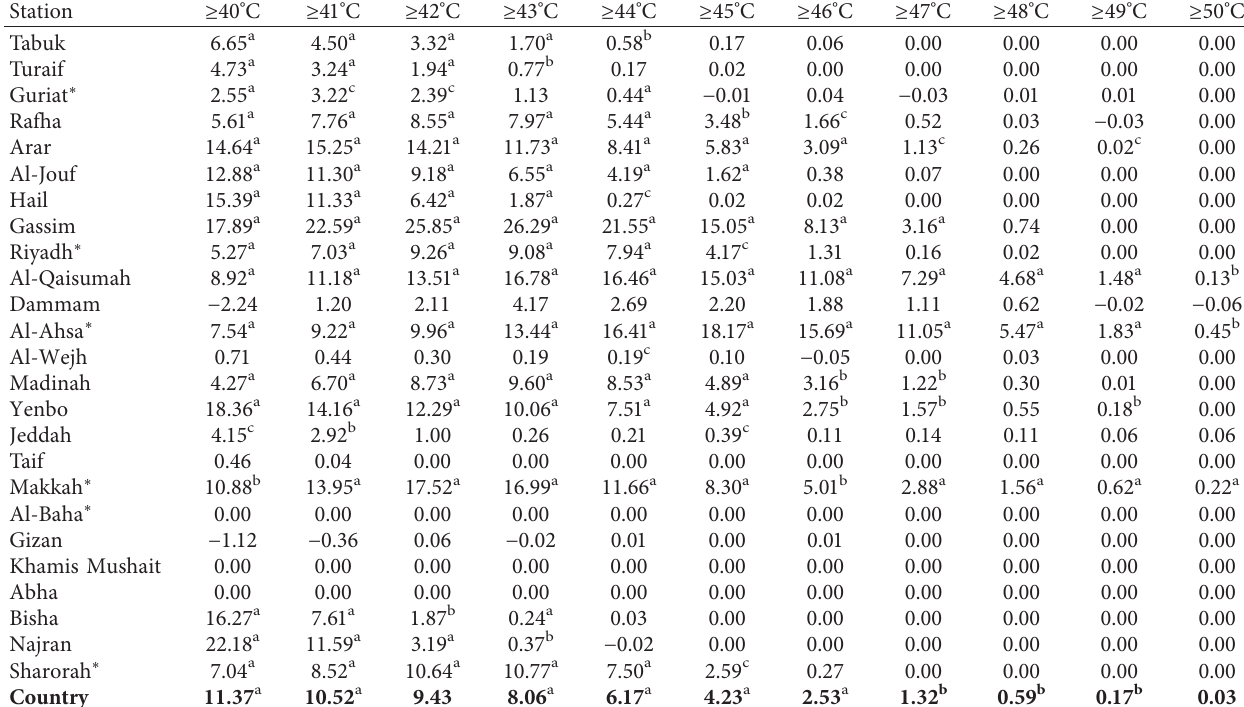
Figure 7: Temperature extreme frequency for (a) TX and (b) TN at different thresholds for 25 station locations in Saudi Arabia for the period 1978–2019. The difference in frequency between the latest two decades (1981–1999) and earlier two decades (2000–2019) at ≥ 48 ° C, ≥ 44 ° C, ≥ 40 ° C, ≤ 10 ° C, ≤ 6 ° C, and ≤ 2 ° C is also shown. The threshold for TX is ≥ 40 ° C to ≥ 50 ° C with an increment of 1 ° C interval while for TN ≤ 10 ° C to ≤ 0 ° C with a decrement of 1 ° C interval. Table 3: Maximum temperature (TX) linear trends ( ° C per decade) at different absolute thresholds in Saudi Arabia for the period